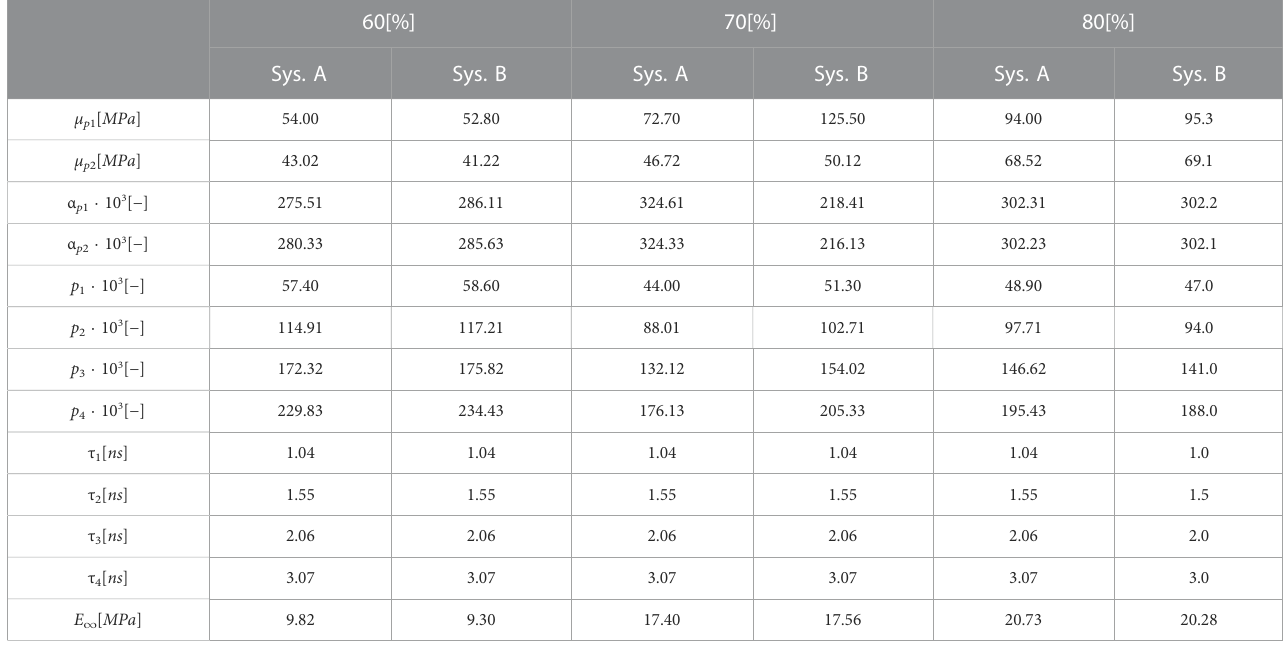
TABLE 2 Parameters for fi ts with Prony series and linear regression of relaxed stress for strain rate of 10 7 1/s. 60[%] 70[%] 80[%] Sys. A Sys. B Sys. A Sys. B Sys. A Sys.